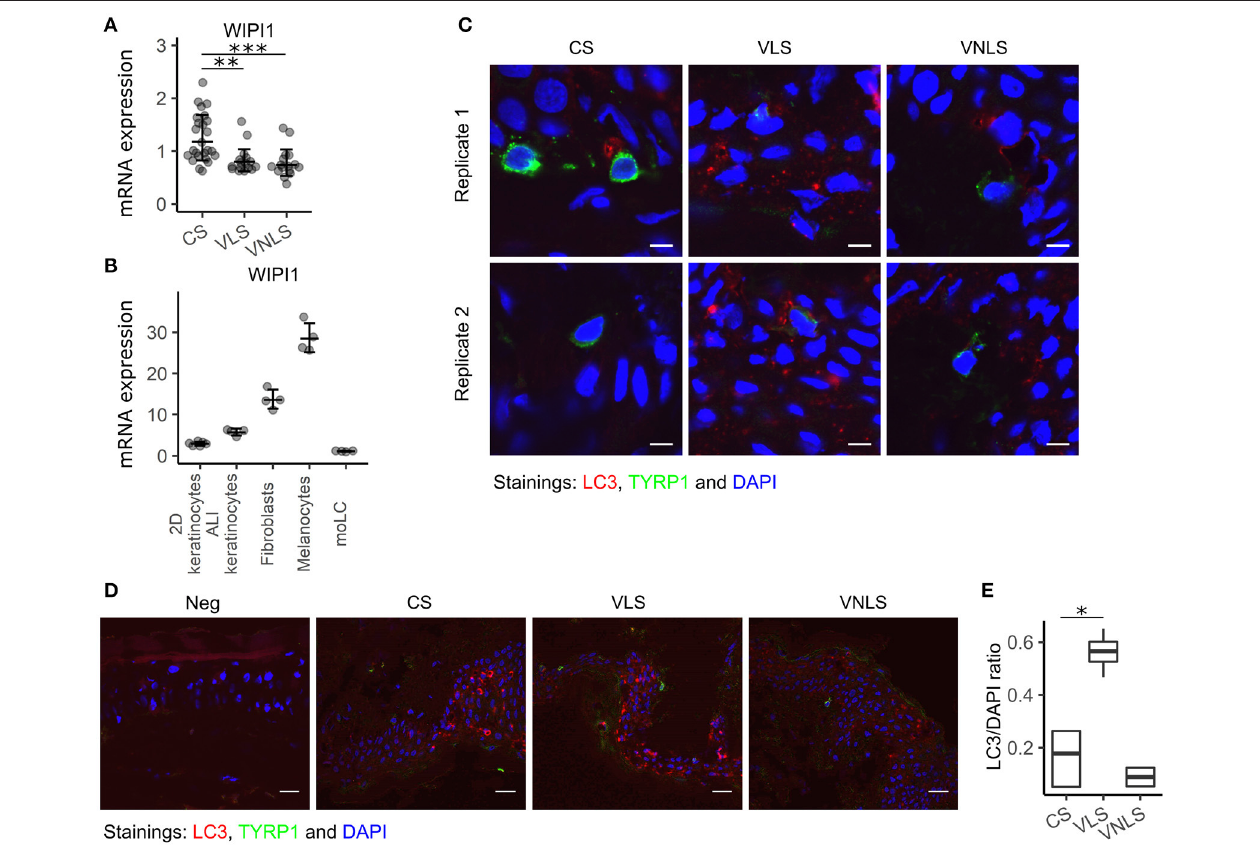
FIGURE 5 | WIPI1 expression and LC3 staining. (A) WIPI1 relative mRNA expression in the skin of control subjects (CS), and in the perilesional skin (VLS) and non-lesional skin (VNLS) of vitiligo patients. Geometric mean ×÷ geometric standard deviation is indicated. ** p < 0.01; and *** p < 0.001. (B) WIPI1 relative mRNA expression in various cell types of the skin. Geometric mean ×÷ geometric standard deviation is indicated. 2D, two-dimensional; ALI, air-liquid interface; moLC, monocyte derived Langerhans cells. (C) Immunofluorescence image of LC3 (microtubule-associated protein 1A/1B-light chain 3) and TYRP1(tyrosinase related protein 1) in sections of biopsy samples from control subjects (CS), and lesional skin (VLS) and non-lesional skin (VNLS) of vitiligo patients. The white bar represents 5 µ m. (D) Immunofluorescence image as in panel C with the white bar representing 20 µ m. Neg. refers to a control slide with secondary antibodies only. (E) The box and whiskers plots show the median and interquartile range of the ratio between the fluorescence signal marking LC3 expression and DAPI (cell nuclei) in CS, VNLS, and VLS. Whiskers cover data points within a 1.5 × interquartile range. * p <